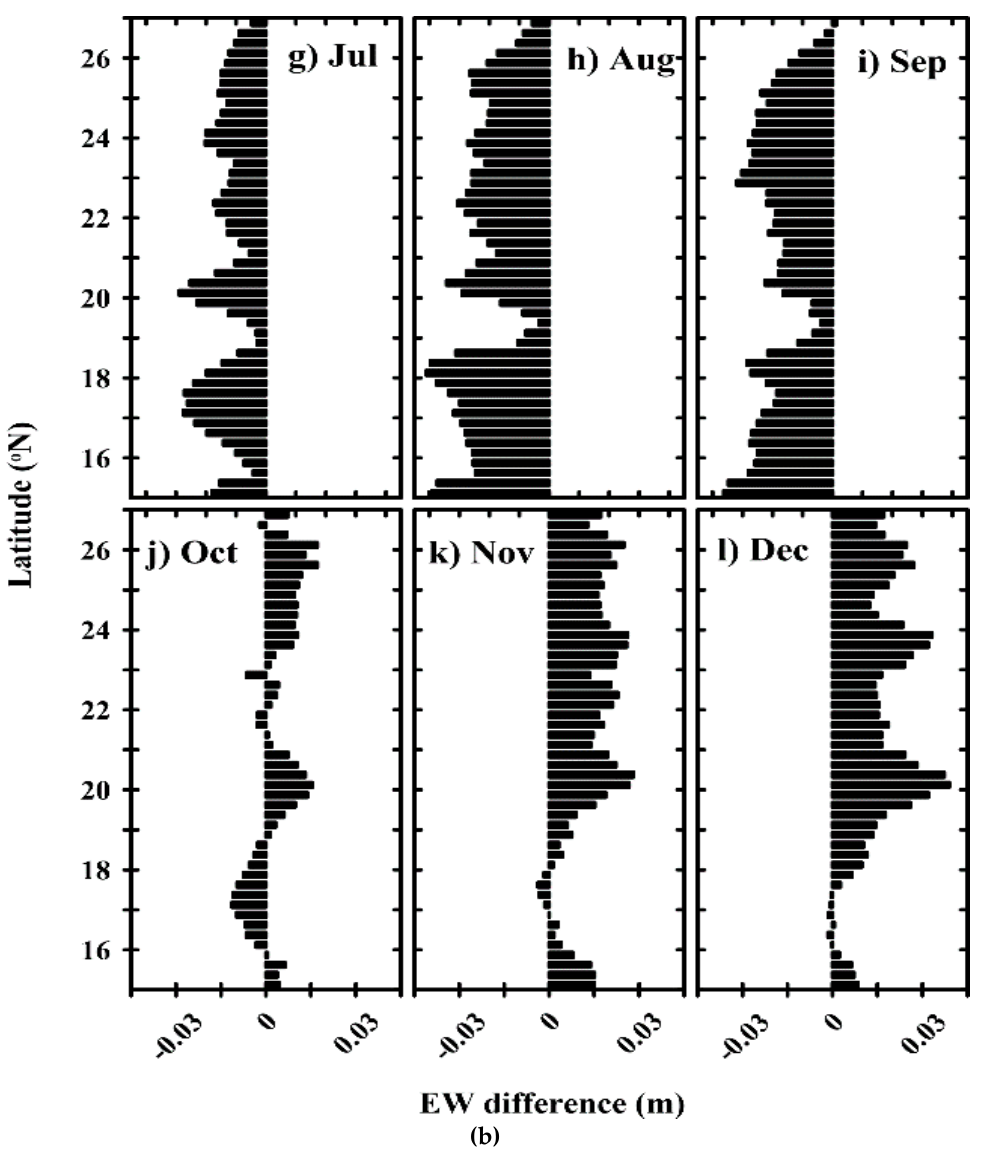
Figure 3. Monthly climatology of EW difference in sea level for different latitudes ( a ) from January to June and ( b ) from July to December.